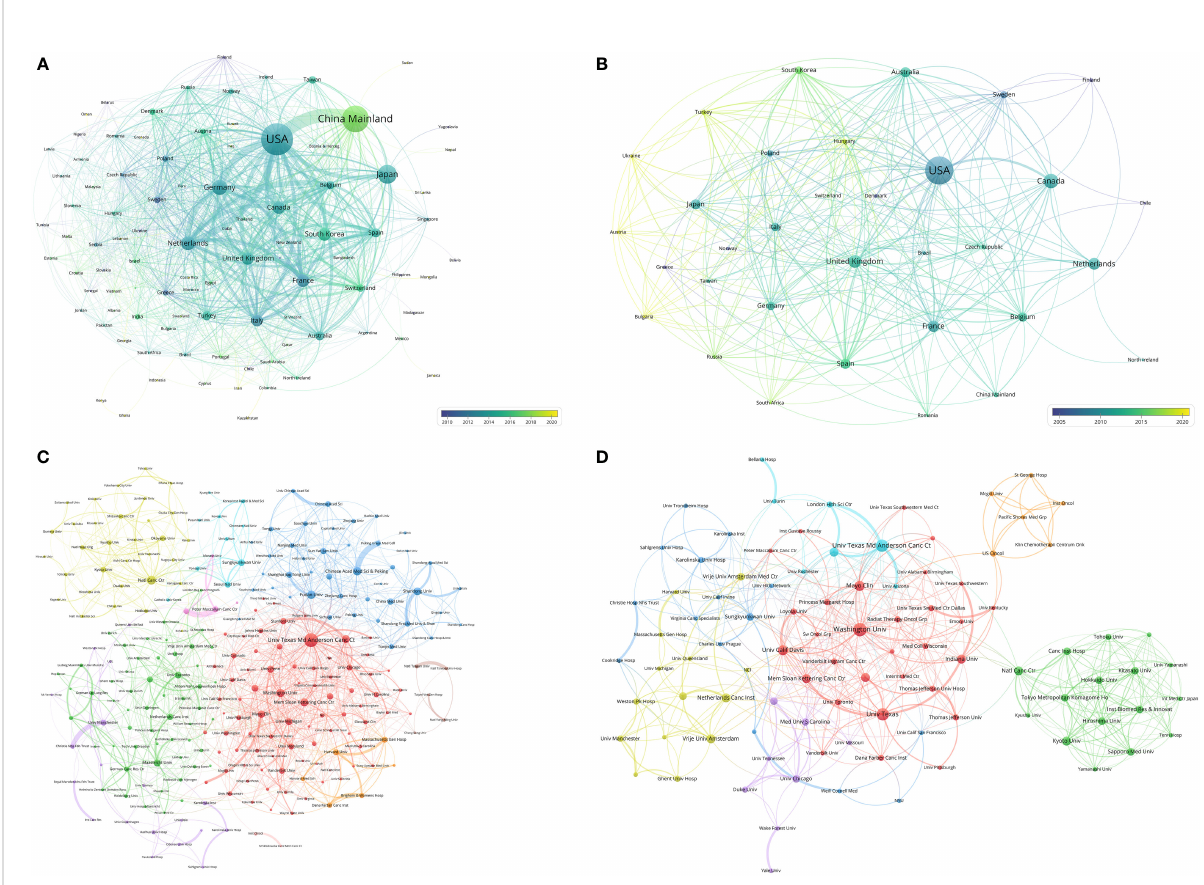
FIGURE 4 (A) Network visualization of countries with papers related to lung cancer radiotherapy. (B) Network visualization of countries with top-papers related to lung cancer radiotherapy. (C) Network visualization of institutions with at least 20 articles related to lung cancer radiotherapy. (D) Network visualization of institutions with at least 2 top-papers related to lung cancer radiotherapy. The circle size represents the number of papers. The breadth of the curves represents the connection strength. The institutions in the same color have stronger collaboration with each